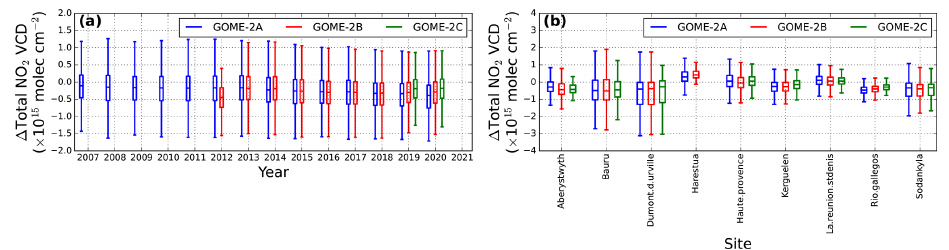
Figure 16. Comparison of total column NO 2 between ground-based ZSL-DOAS and GOME-2 observations. Data are sorted by year in panel (a) and measurement site in panel (b)